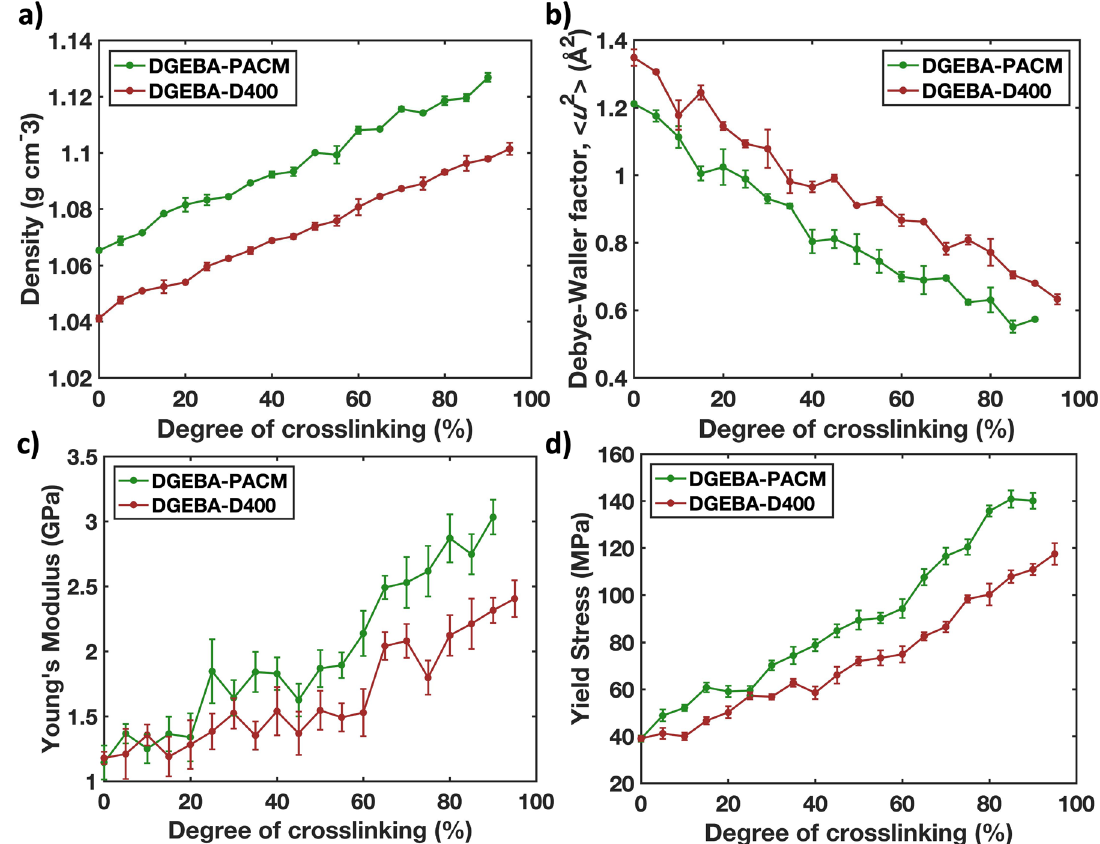
Fig. 2 Target macroscopic properties of the AA simulations. a density, b Debye-Waller factor 〈 u 2 〉 , c Young ’ s modulus, and d yield stress as a function of DC for the DGEBA + PACM and DGEBA + D400 systems. Error bars result from the variance of statistically independent simulations. Density, modulus, and yield stress increase with increasing DC, while 〈 u 2 〉 , related to the mobility of the system, decreases. The D400 system, with the longer and fl exible curing agent, has a lower density, higher mobility, and softer mechanical response. The dependence of these properties on DC is different in the CG model due to the different changes in con fi gurational entropy caused by the reduction in degrees of freedom. This is typically discussed for changes in temperature, and here observed during the curing process of the polymer network. For this reason, a DC-independent parametrization of the CG model cannot fully capture the features of the AA model at all DC values (see Supplementary Figs. 2 and 3), and an energy renormalization procedure is